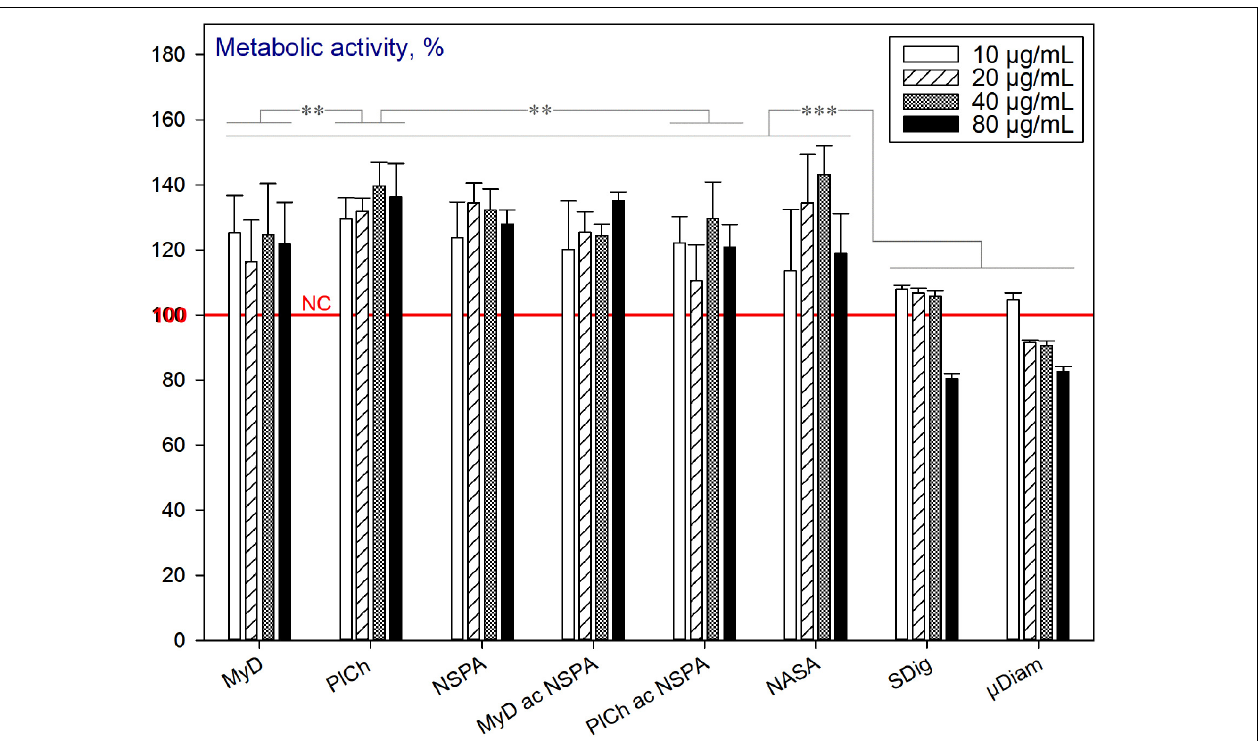
FIGURE 10 | Metabolic activity of HDFs cultured with completely purified (“end-of-cycle”) nano- and micronsized diamonds for 72 h, using the alamarBlueTM assay (normalised to the non-treated cells; n = 3; ∗∗∗ p < 0.001; ∗∗ p < 0.01; ∗ p < 0.05; ± SD).